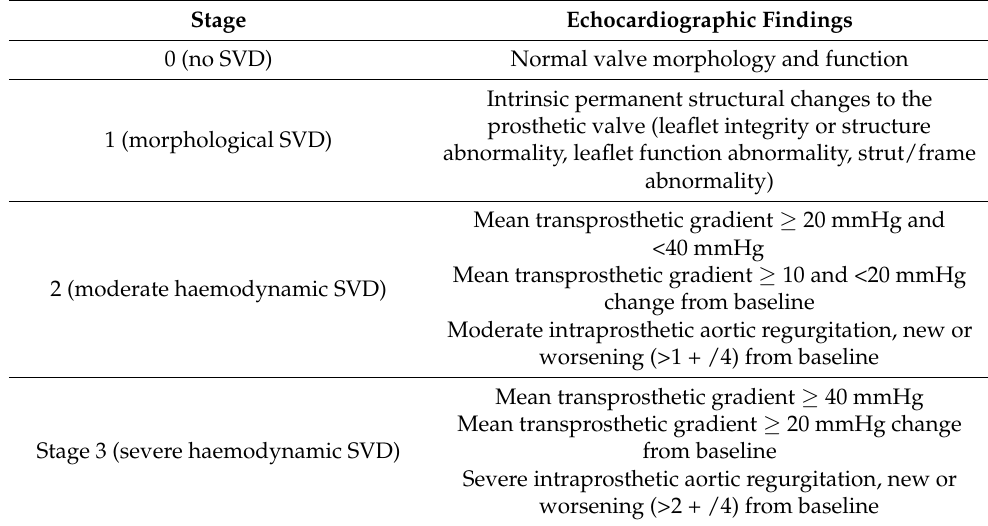
Table 3. SVD scale provided by EAPCI [23].